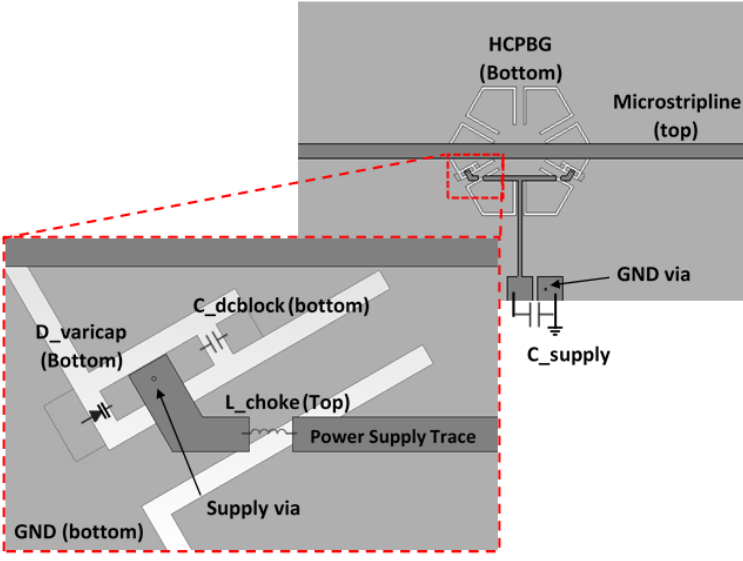
Figure 12. Reconfigurable HCPBG—detailed simulation design view. Table 4. Reverse voltage ( V R ) versus capacitance ( C T ) of SMV1247 varactor diode.